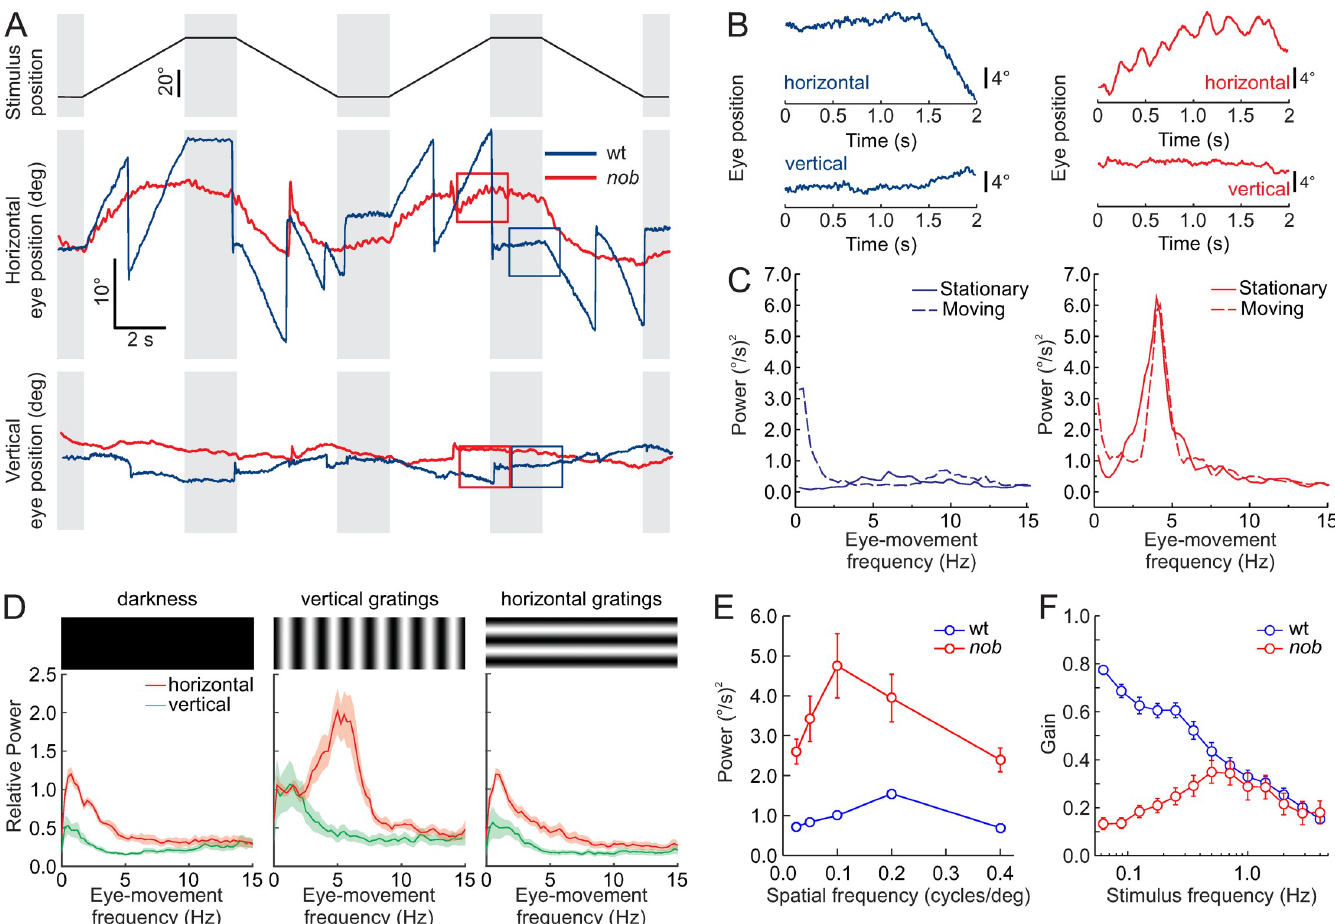
Fig 1. Horizontal eye movements are disturbed in nob mice. (A) Schematic diagram of the timing of the stimulus used to evoke eye movements: 0.1 cycle/deg sine wave grating stimulus of 90% contrast moving at 10 deg/s (Top panel). Raw horizontal (middle panel) and vertical (bottom panel) eye movements are compared for wt (blue lines) and nob (red lines) mice. All nob mice tested behaved similarly ( n = 9). (B) Two-second segments taken from the boxes in (A), on an expanded scale, show small-amplitude oscillating eye movements in nob (right) but not in wt (left) mice. These 2-s segments illustrate that wt mice made smooth eye movements in the presence of the moving contrast, whereas the eyes of nob mice oscillated in the horizontal direction. In both wt and nob mice, vertical eye movements were generally absent. (C) Power spectral density plots of the eye-movement velocity show an approximately 5-Hz oscillation frequency in nob mice (right) during moving and stationary stimuli, whereas the eyes of wt mice (left) did not oscillate under those conditions. The peak in the power spectrum for the moving stimulus (0.5 Hz) in wt results from stimulus-induced eye movements. (D) Relative power spectral density plots comparing nob eye movements ( n = 9) in darkness (left panel), during vertical sine grating presentation (middle panel), and during horizontal sine grating presentation (right panel). A vertical grating with a spatial frequency of 0.1 cycles/deg effectively induced eye-movement oscillations, whereas a horizontal grating of the same spatial frequency did not. (E) The relation between spatial frequency and power of the eye-movement oscillations in the same mice. A spatial frequency of 0.1 cycles/deg was the most effective. Oscillating eye movements were absent in wt mice ( n = 9). (F) Frequency-response plots of the OKR, tested by projecting a horizontally oscillating dot pattern (peak velocity of 18.85 deg/s) on a screen around the mouse. The eye-movement gain is expressed as the average velocity amplitude of the eye-movement response divided by the velocity amplitude of the stimulus. In wt mice (blue line; n = 11), the gain drops with increasing oscillation frequency. The eye-movement gain of n ob mice (red line; n = 9) deviates from that of wt at low frequencies. Data in (D-F) are shown as mean ± SEM. The data underlying this figure can be found at https://figshare.com/account/home#/projects/65990. OKR, optokinetic response; wt, wild type.